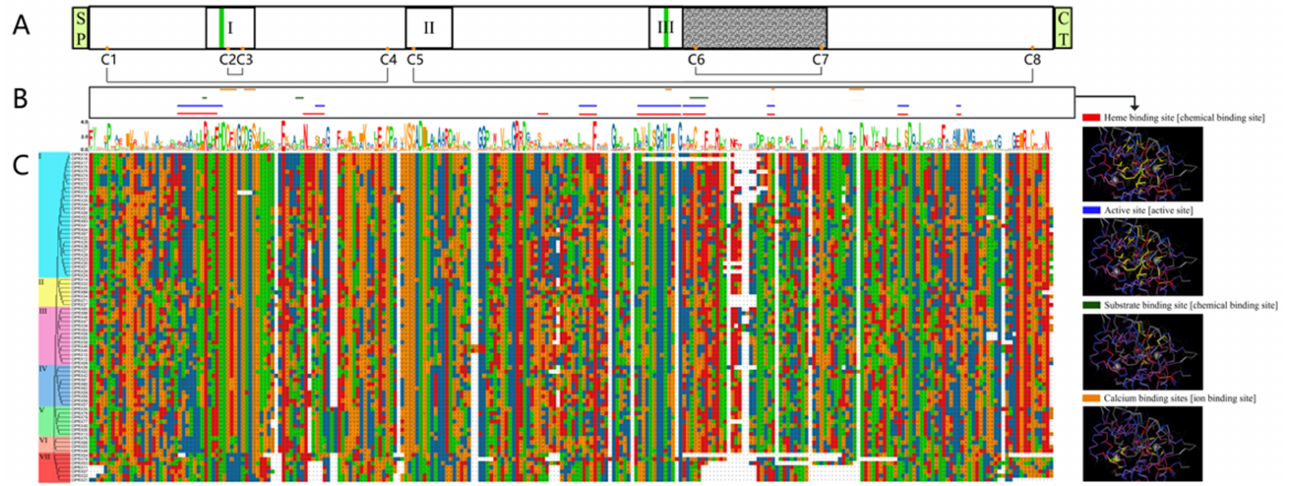
Figure 4. Structural characteristics of ClPRX protein. ( A ) Schematic diagram of the primary structure of the class III peroxidase. The green boxes at the front and back signify the N-terminal signal peptide (SP) and c-terminal extension domain (CT). The middle three boxes represent the highly conserved domain: box I is the distal-heme-binding site domain; box Ⅱ is the unknown functional domain; box Ⅲ is the proximal-heme-binding site domain. The gray area with obvious variation was assumed to be a variable domain responsible for the specific catalytic function of peroxidase. The highly conserved distal histidine (Hd) and proximal histidine (HP) are heme-binding sites represented by green bars. Eight cysteines (C1–C8) are key amino acids that form disulfide bonds to form the secondary structure of peroxidase, which are represented by yellow solid circles. The four conserved disulfide bonds formed are shown as black lines in plane. ( B ) represents the four conserved domains and site location information of the third type of peroxidase, which are marked on the amino acid sequence with four different colors, and the 3D model of the structure of the four domains is displayed, the yellow part being the functional site. ( C ) is the comparison results of 7 groups of ClPRX protein sequences.